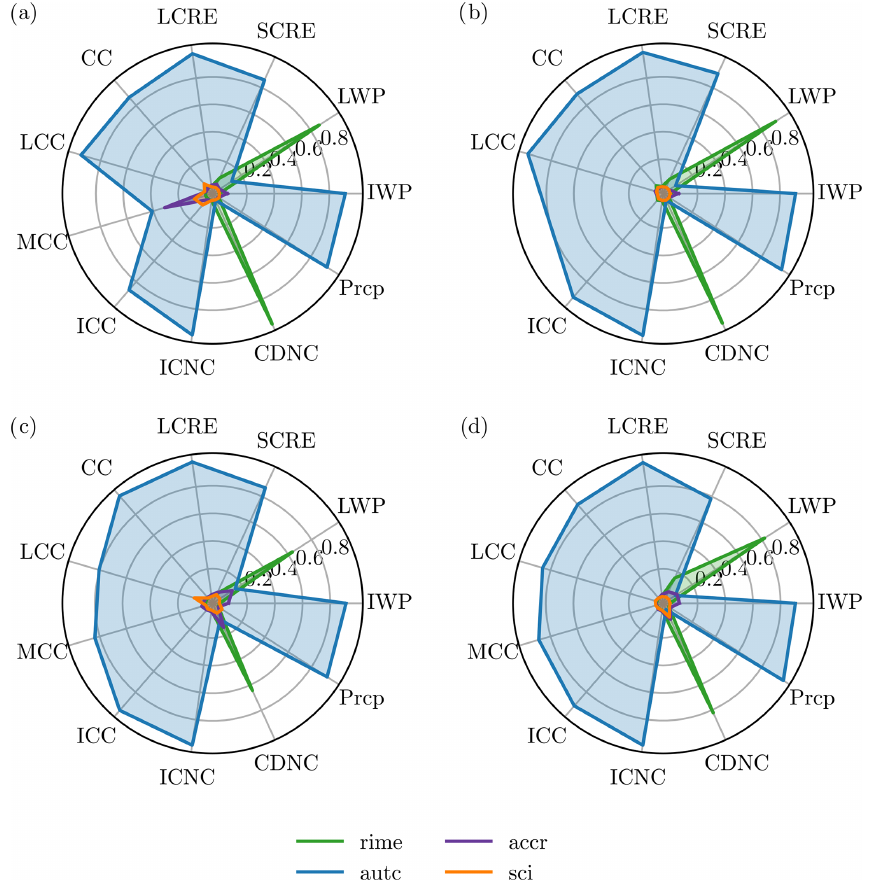
Figure 12. Same as Fig. 9 but with seasonal means ( a : DJF, b : MAM, c : JJA, d : SON) and only first-order sensitivity indices shown. The results for the total sensitivity index are shown in Fig. C2 in Appendix